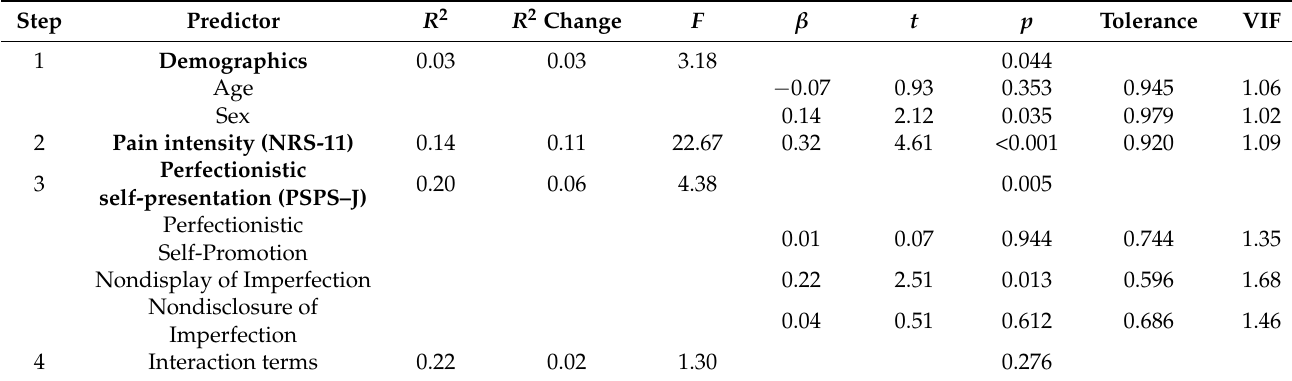
Table 6. Regression analysis explaining pain interference